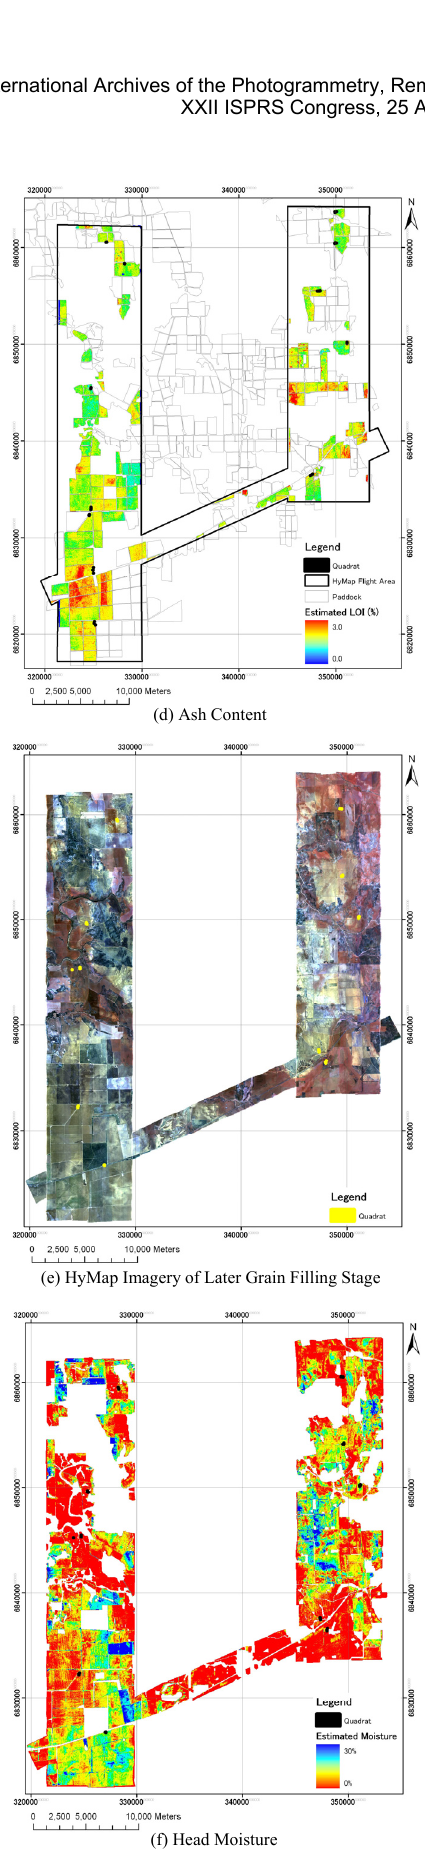
Figure 7: Estimation Maps based on HyMap